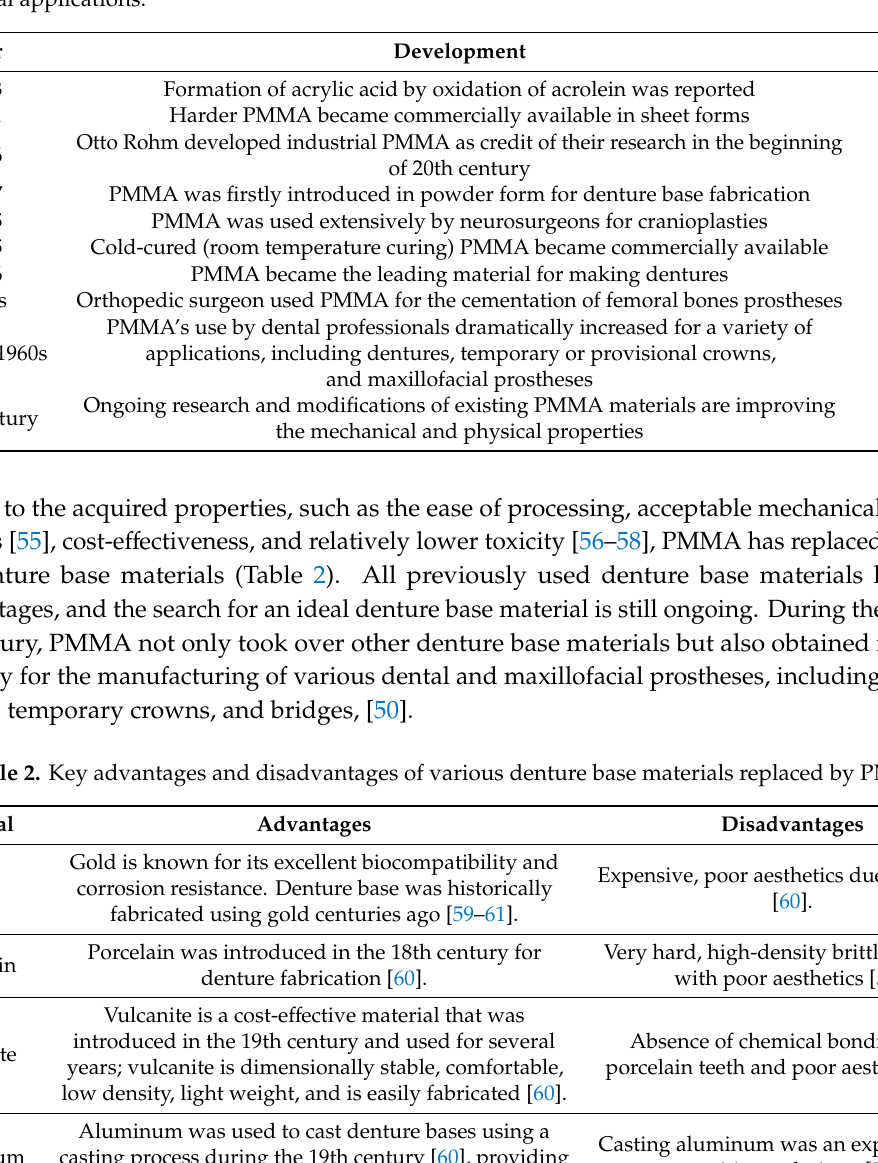
Table 1. Chronology of the development of poly methyl methacrylate (PMMA) materials for dental applications.